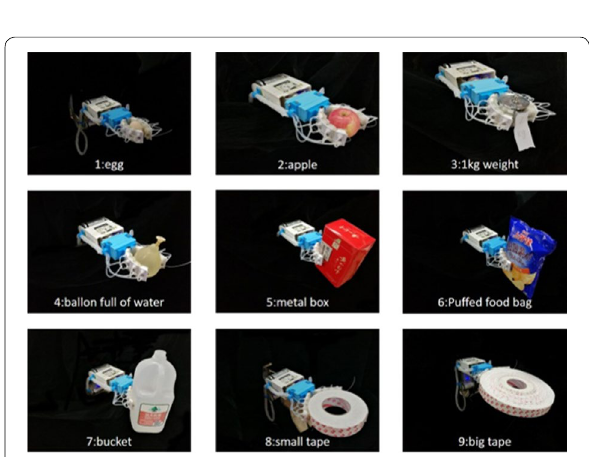
Figure 11 Grasp various objects using the STU hand (Additional file